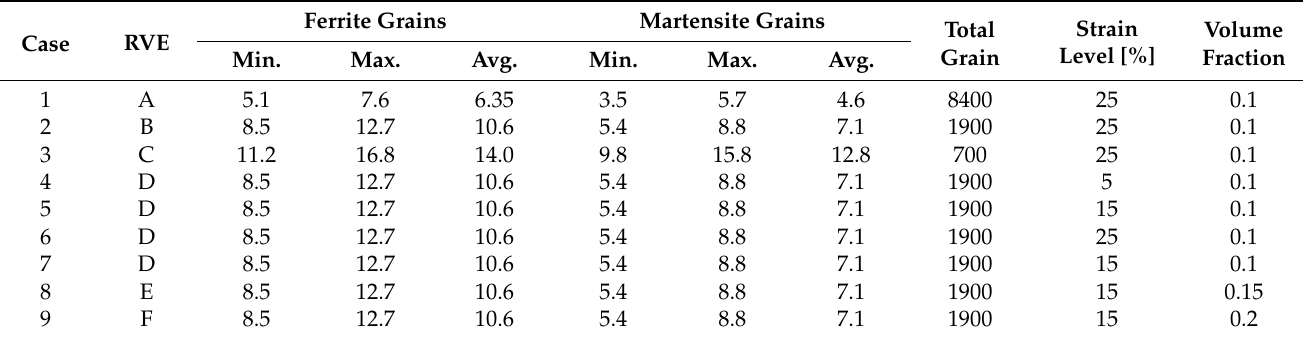
Table 1. Grain size distribution, number of total grain, volume fraction, and strain level for the microstructure